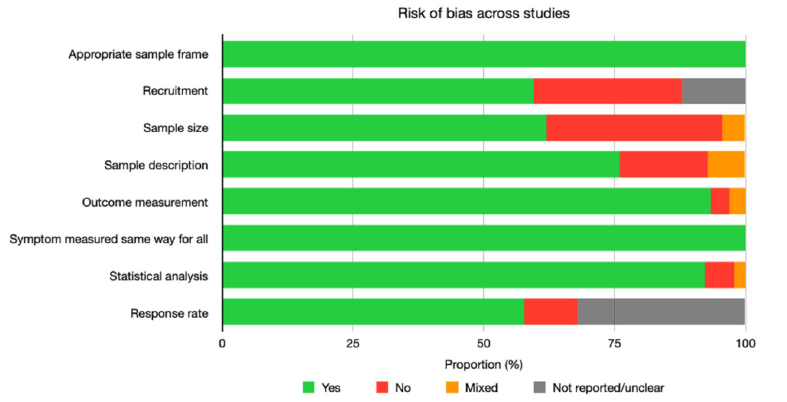
Fig 11. Quality of included studies. Yes = appraised as adequate; no = appraised as not adequate.